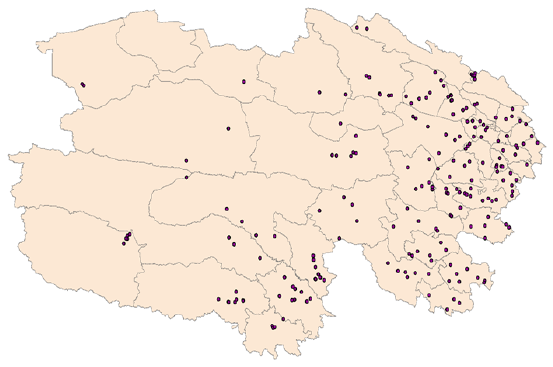
Figure 3. The distribution map of the samples for modelling The multiple linear regression model is as